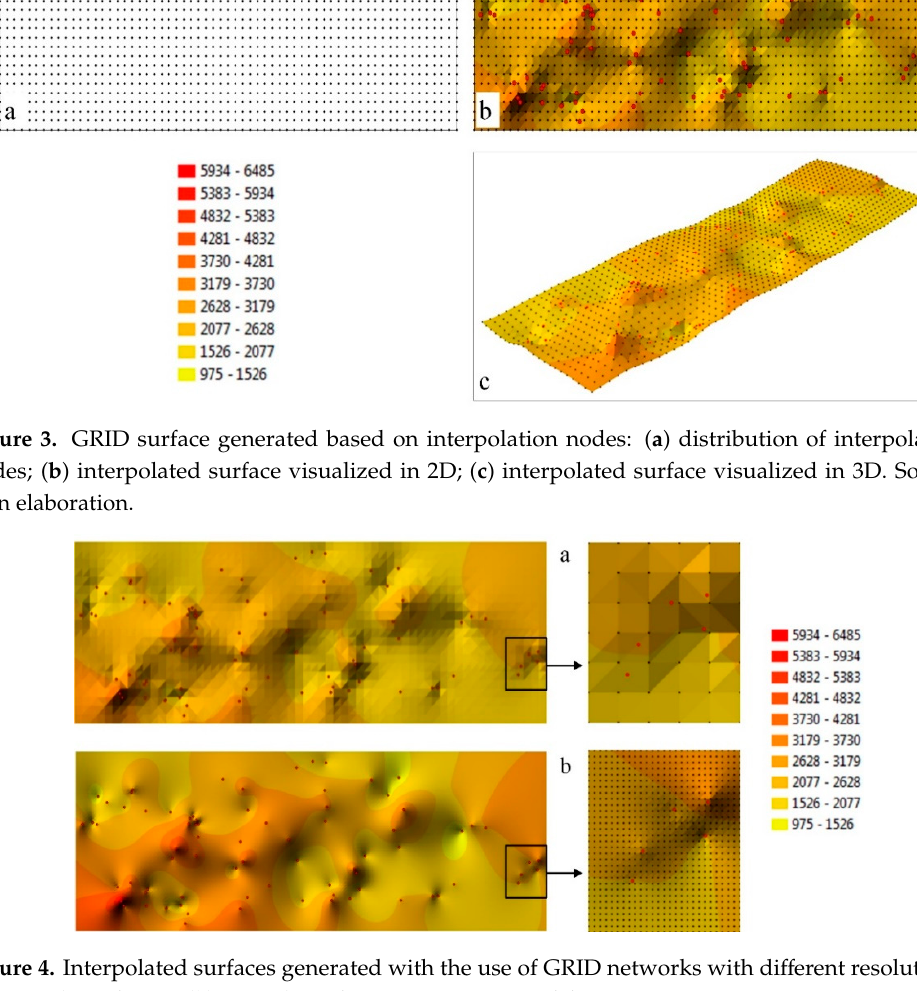
Figure 4. Interpolated surfaces generated with the use of GRID networks with different resolutions: ( a ) 0.0005° resolution; ( b ) 0.0001° resolution. Source: own elaboration.